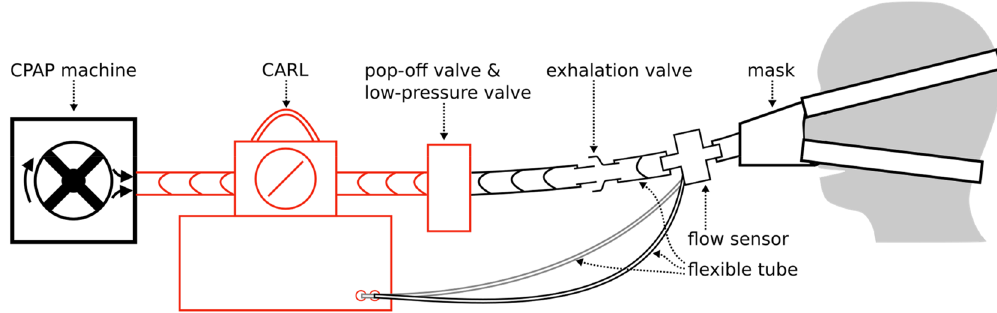
Figure 6. Schematic of a basic ventilator with a CPAP machine and the module CARL.